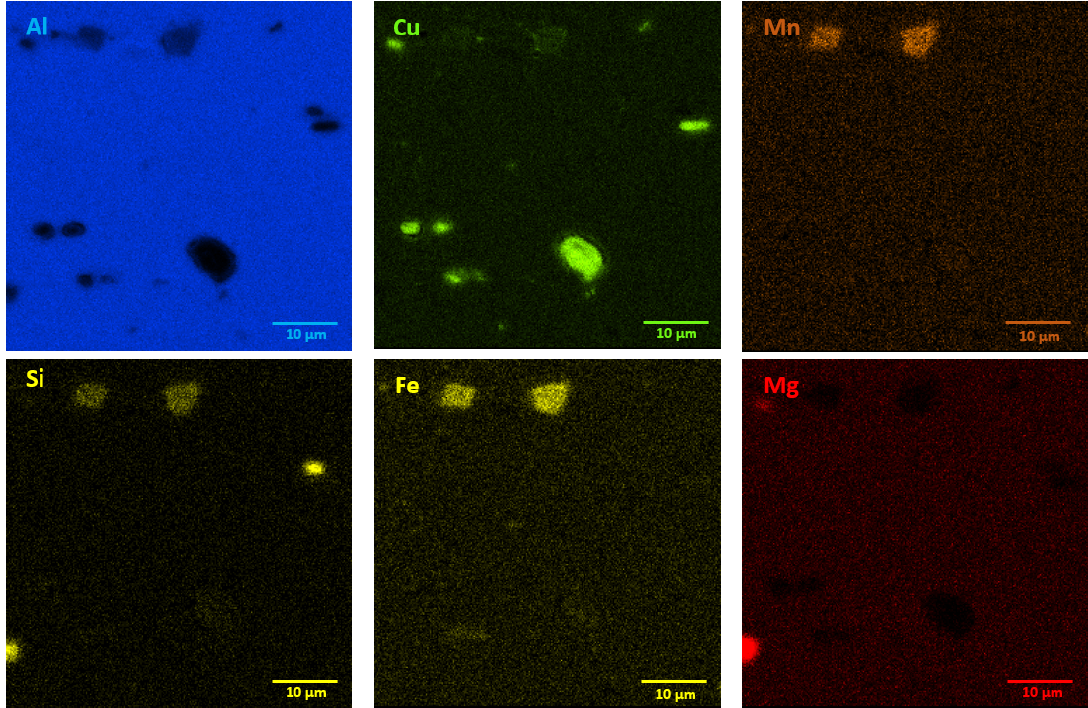
Figure 3 . EDS mapping showing precipitates in bare AW-2024-T3 alloy in the initial state.